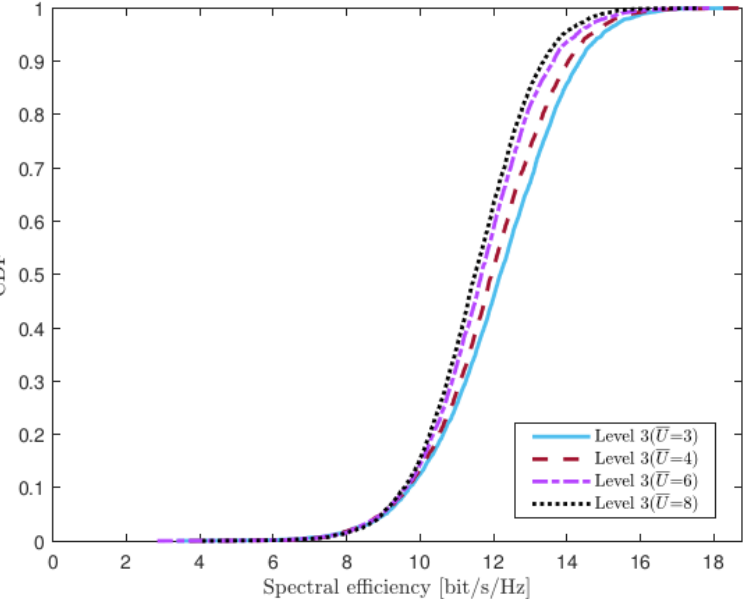
Figure 5. When the total number of APs is fixed, the SE comparison of different number of CPUs.